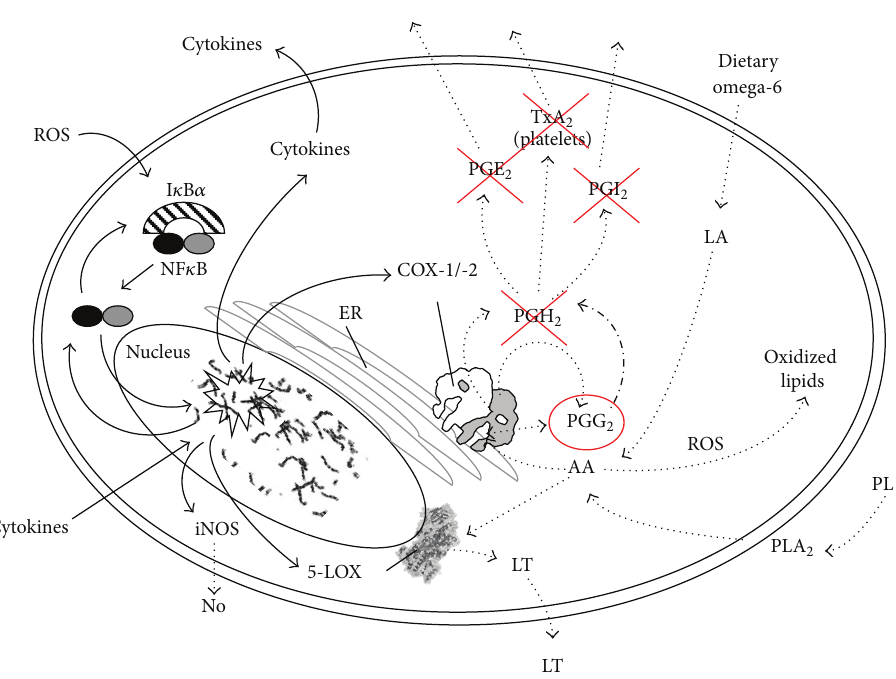
Figure 4: Mode of action of flavocoxid on cellular